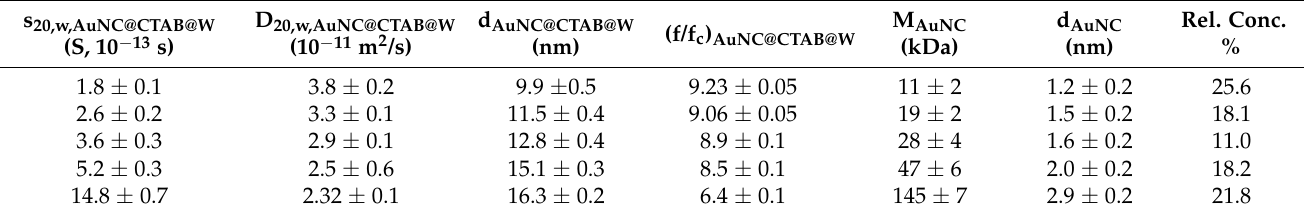
Table 3. AuNC data obtained from the analysis of their sedimentation velocity behaviour at 450